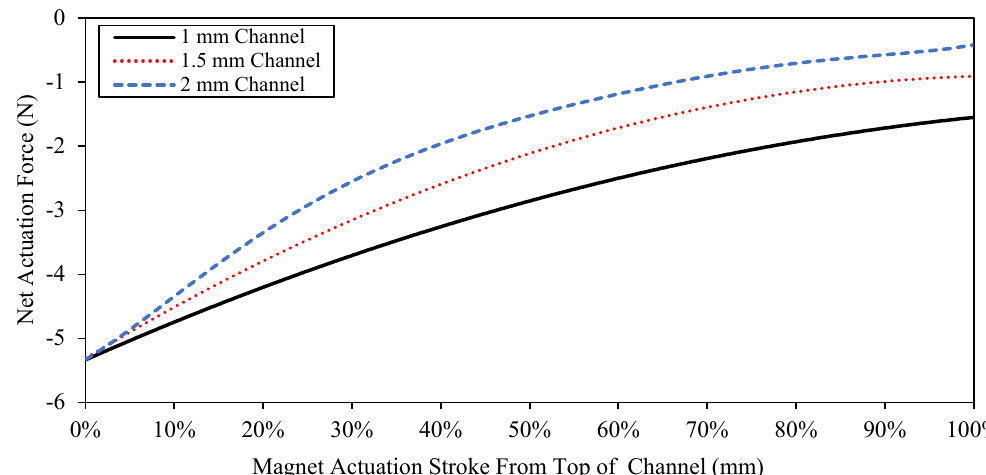
Figure 13. Net repulsion force estimated on the permanent magnet during its stroke along the actuator actuation channel.